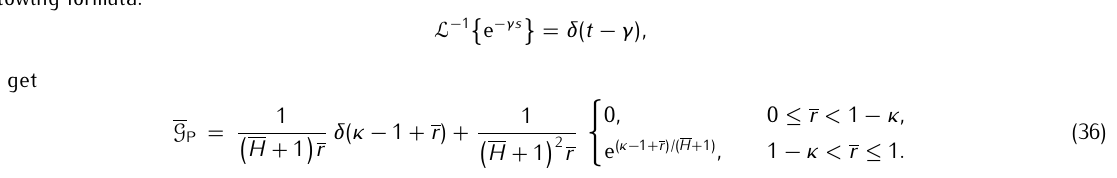
Figure 2. Dependence of fundamental solution G